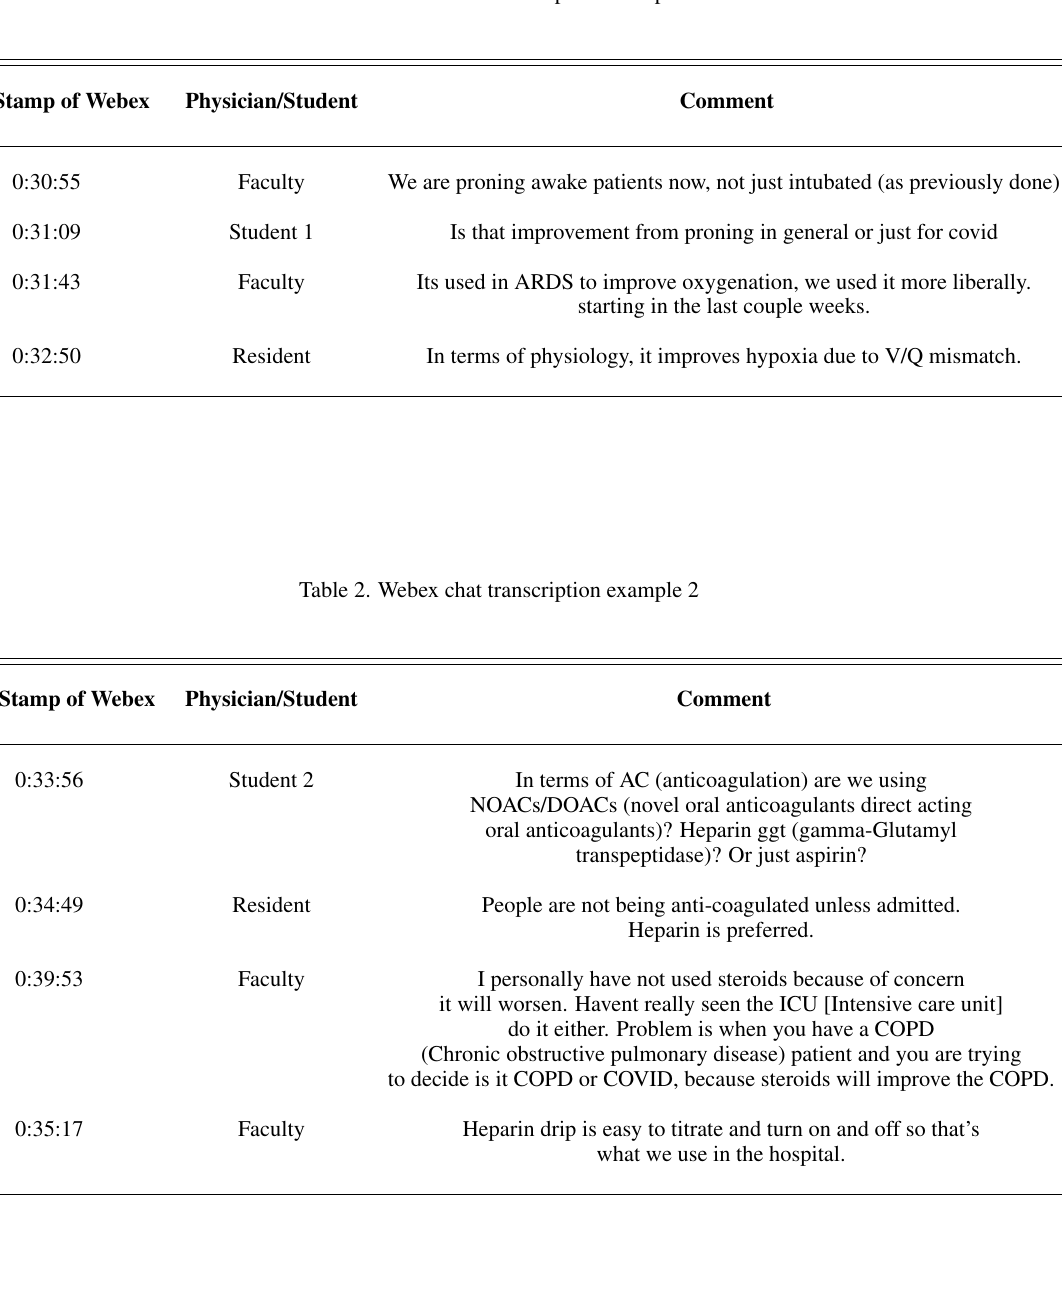
Table 1. Webex chat transcription example 1